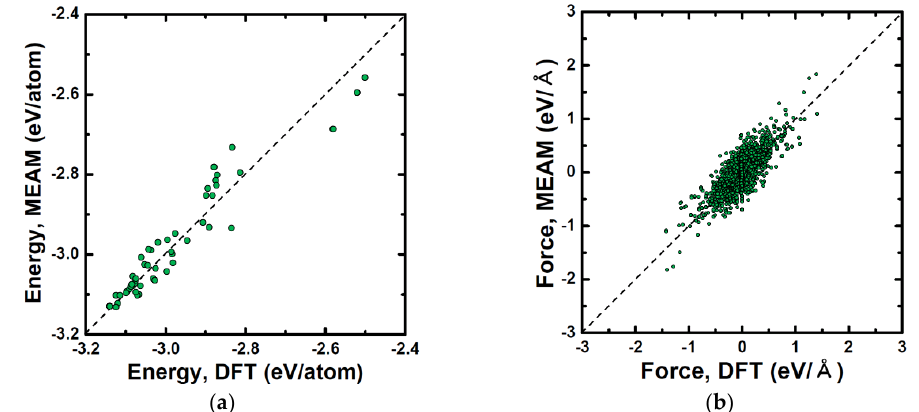
Figure 1. Scatter plots for ( a ) energies and ( b ) forces of pure Sn with respect to the DFT database. The dashed lines indicate a perfect correlation between the present 2NN modified embedded-atom method (MEAM) and the DFT values.